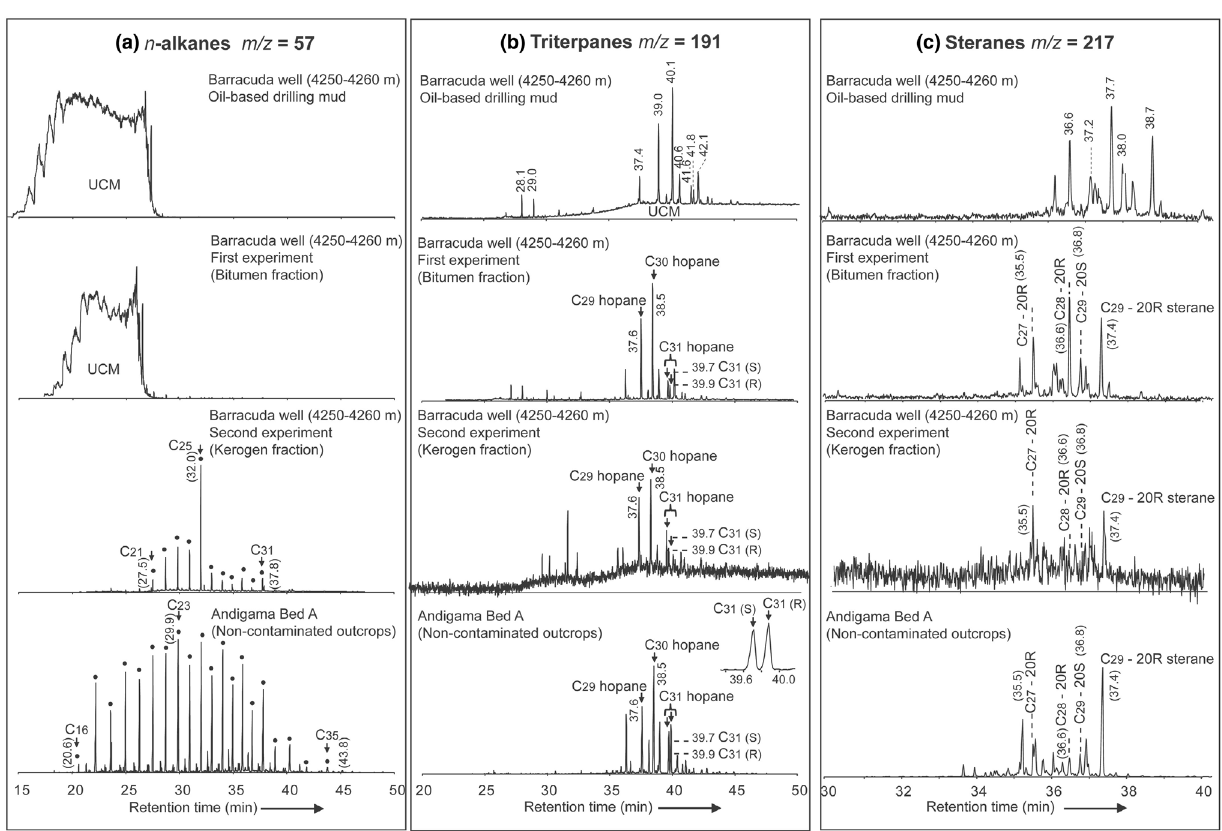
Fig. 3 Comparison of representative a n -alkanes, b triterpanes, and c steranes fractions in oil-based drilling mud, cleaned rock cuttings (first experiment), cleaned rock cuttings (second experiment) from